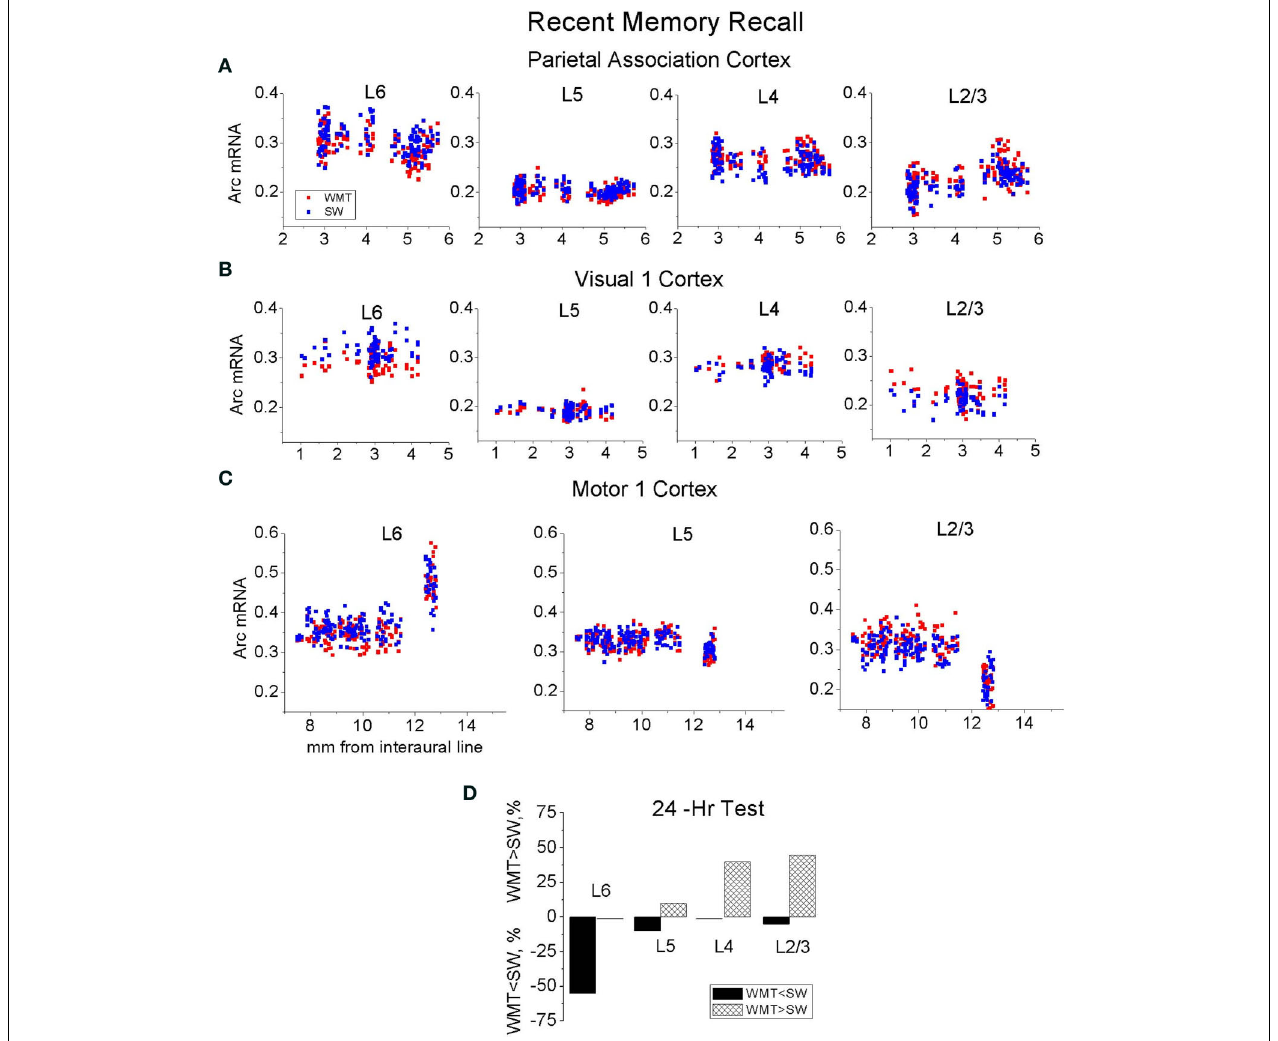
FIGURE 6 | The stereotypical patterns in Arc laminar redistribution appeared after recent WM recall. Performances on a recently learned WM task-induced increased Arc mRNA fractions in the upper layers L4 and L2/3, and decreased Arc fractions in L6 without consistent changes in L5 within the parietal association (A) , V1 (B) and M1 (C) cortices. (D) A summary plots